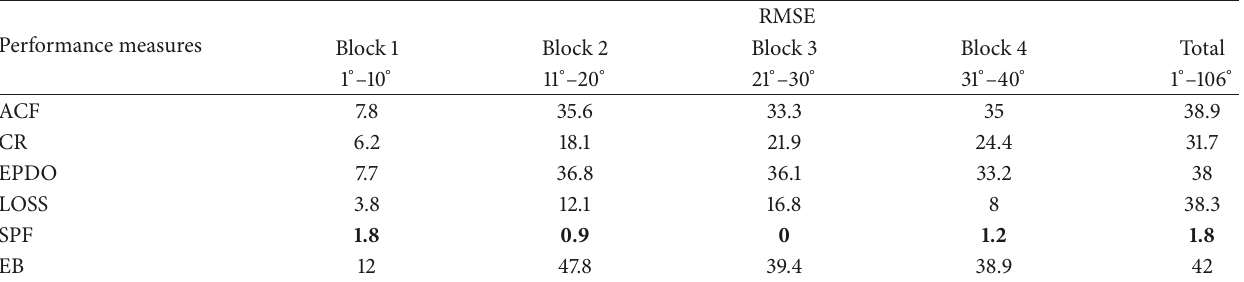
Table 3: Root means square error of performance